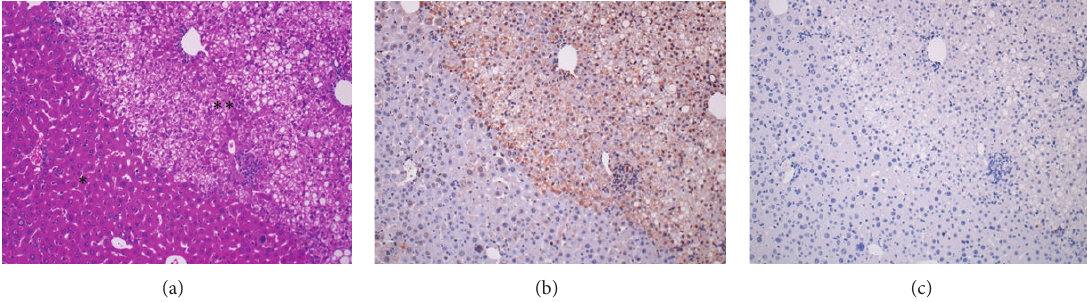
Figure 2: Confirmation of the specificity of LNA-based ISH. (a) HE stain, (b) ISH after DNase treatment, (c) ISH after RNase treatment, ( ∗ ) mouse hepatocytes, and ( ∗∗ ) human hepatocytes. The mouse hepatocytes are densely eosinophilic, while the human hepatocytes appear pale with deposition of fat droplets. HCV-RNA is observed only in the human hepatocytes in the chimeric liver infected with HCV genotype 1b. The HCV-RNA signals are resistant to DNase treatment but disappear after RNase treatment.